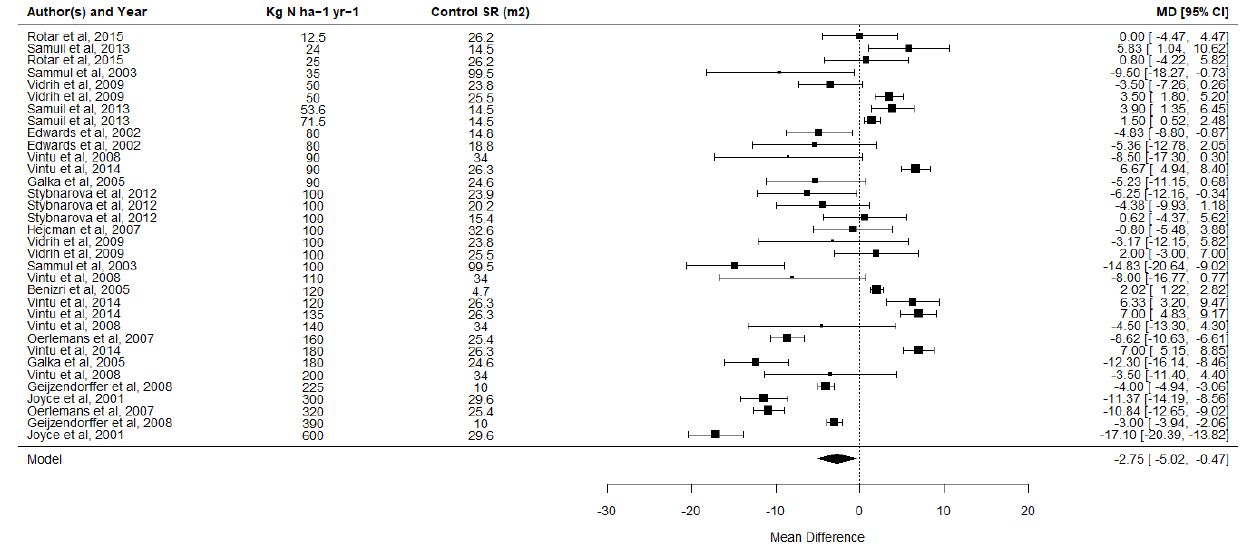
Figure 1. The effects of nitrogen (N) fertilisation on the mean difference (MD) in plant species richness for 34 effect sizes in 14 studies conducted on European permanent grasslands included in a meta-analysis. A mean difference of zero would indicate no change in species richness, whereas negative values indicate the number of species lost and positive values the number of species gained between zero N controls and N addition treatment. Error bars show 95% confidence intervals, and MD and 95% CIs are given in the right column for each effect and for the overall model. Nitrogen application rates and control species richness (SR) values are shown for each effect. Effects are ordered in ascending order of nitrogen treatment rate.